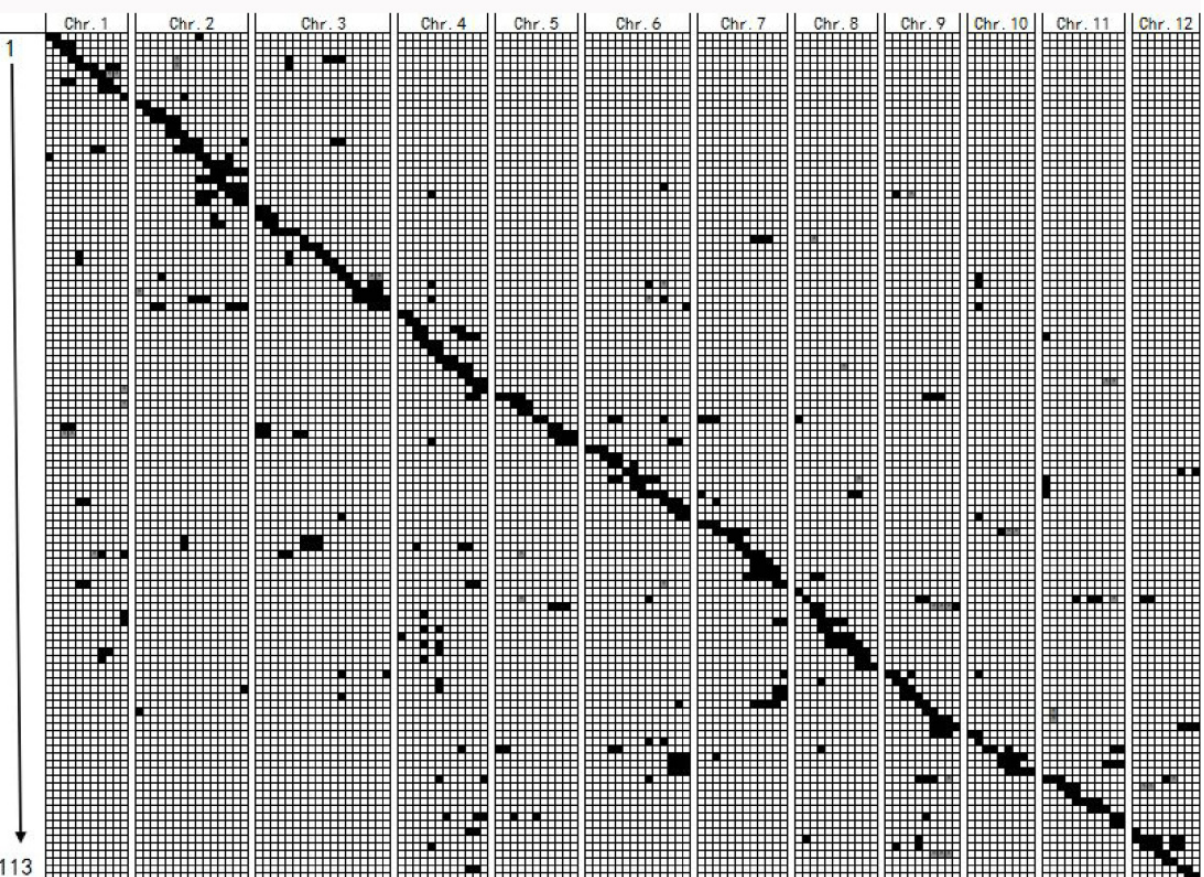
Figure 3. Graphic of genotypes of the 113 CSSLs. Black regions indicated homozygous segments,